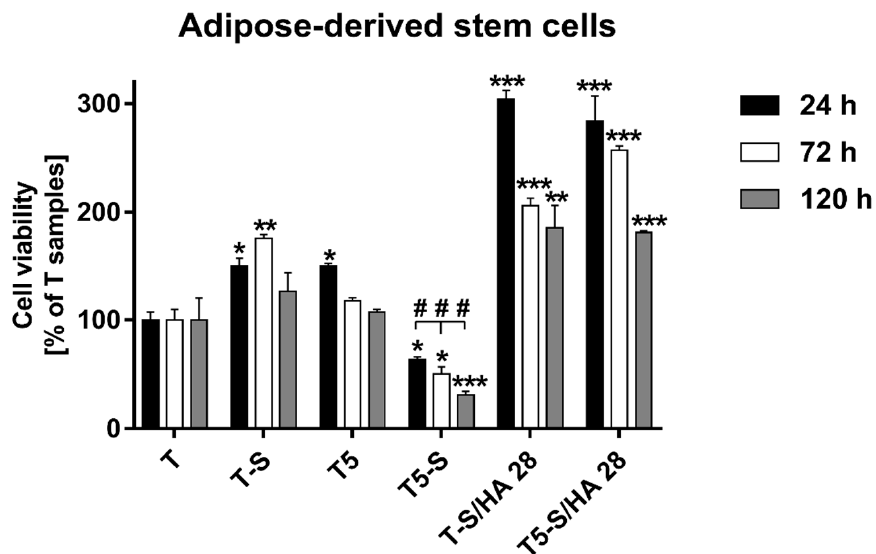
Figure 11. Viability of adipose-derived mesenchymal stem cells (ADSCs) cultured on the tested samples for 24, 72, and 120 h. The results are expressed as the mean ± SEM and presented as a percentage of the cells cultivated on the T samples (served as 100%). Asterisks indicate differences when the viability of cells growing on the tested scaffolds was higher in comparison with T samples (*** p < 0.001, ** p < 0.01, * p < 0.05). Pound signs denote differences between the cells cultured on the T5-S scaffolds and T-S samples (### p < 0.001).